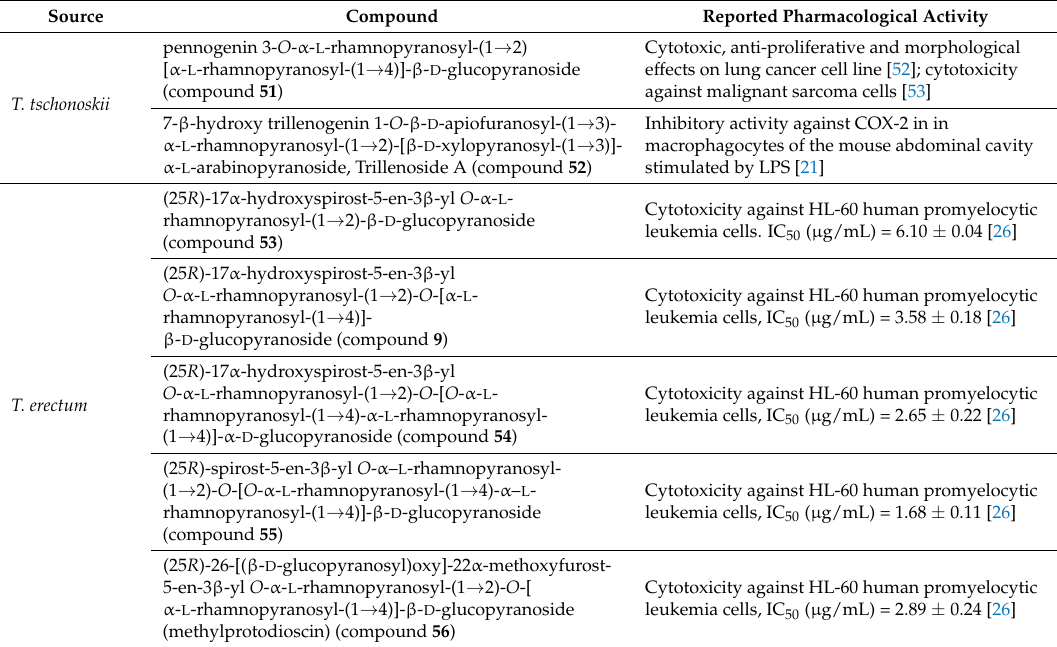
Table 3. Bioactivities of the genus Trillium